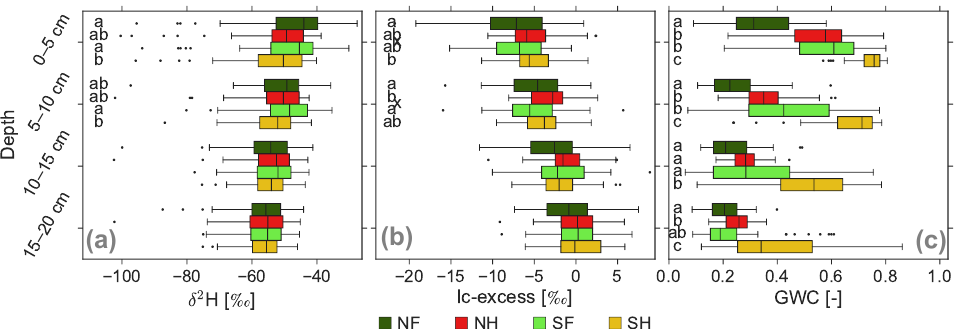
Figure 5. Site specific (a) δ 2 H, (b) lc-excess, and (c) gravimetric water content (GWC) for the soils at the four study sites summarized for each site over all sampling dates as function of depth. For depths, where letters are shown, different letters indicate significant differences between the sites for the specific depth.